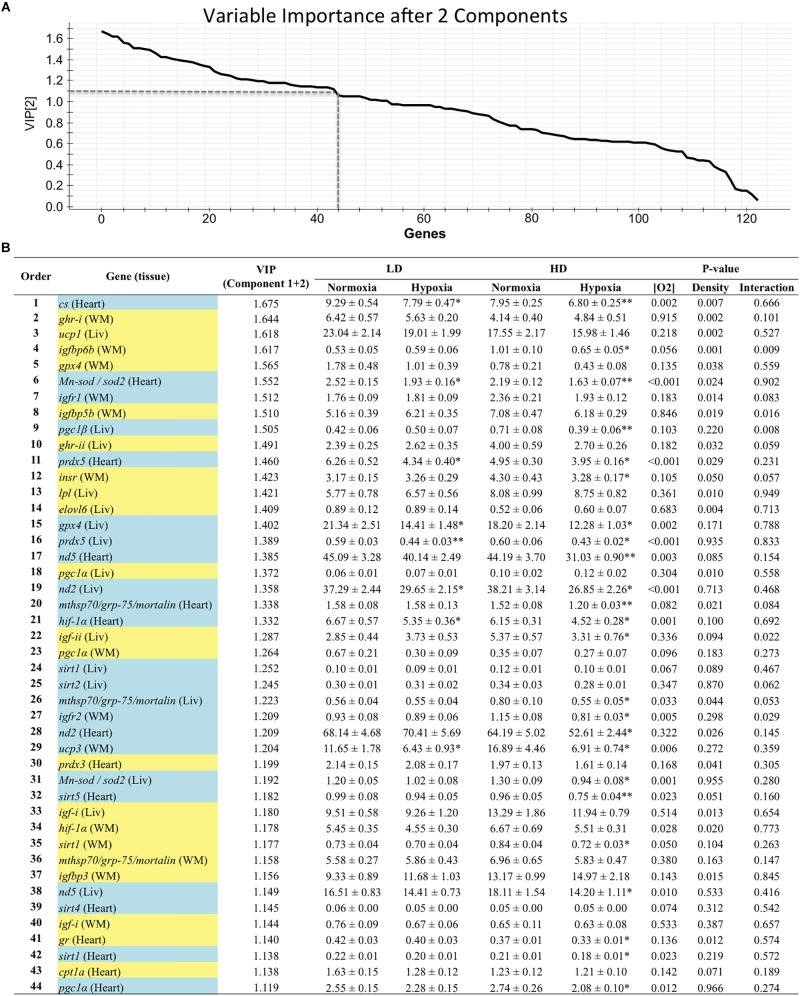
(A) Graphical representation of the variable importance (VIP) scores after component 2. (B) Ranking list of genes showing VIP score values above 1.1 and their relative gene expression. Cells shaded in blue highlight genes detected as VIP after component 1; cells shaded in yellow highlight genes detected as VIP after component 2. For further details, see legend on Figure 2.